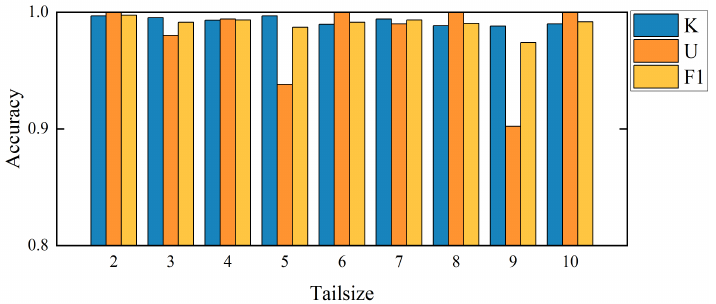
Figure 14. The relationship between the tailsize value and precision of the PHM2009